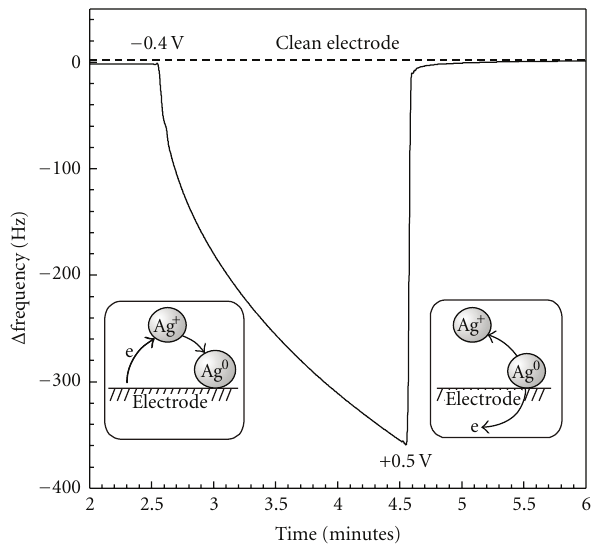
Figure 1: EQCM data highlighting the deposition and stripping of